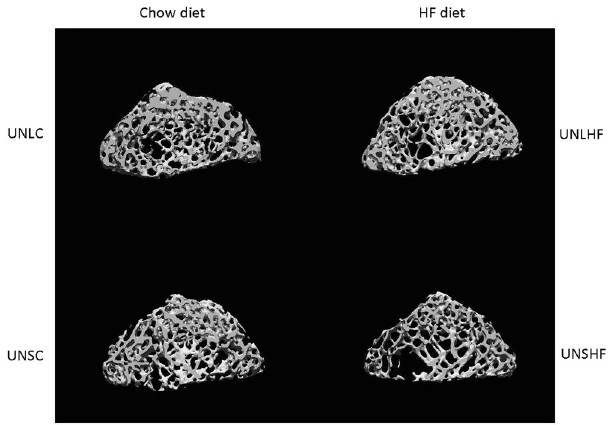
Figure 4. MicroCT processed images of the metaphyseal volume of interest of the animal closest to the median Tb.Sp value for the four UN groups. Abbreviations are those in text and the Fig. 1 legend. The Tb.Sp and Tb.N values (Fig. 3) are visibly most abnormal in the UNSHF image (bottom right), and reversed by leptin in the UNLHF group, values in which are similar to those of the UN chow-fed control